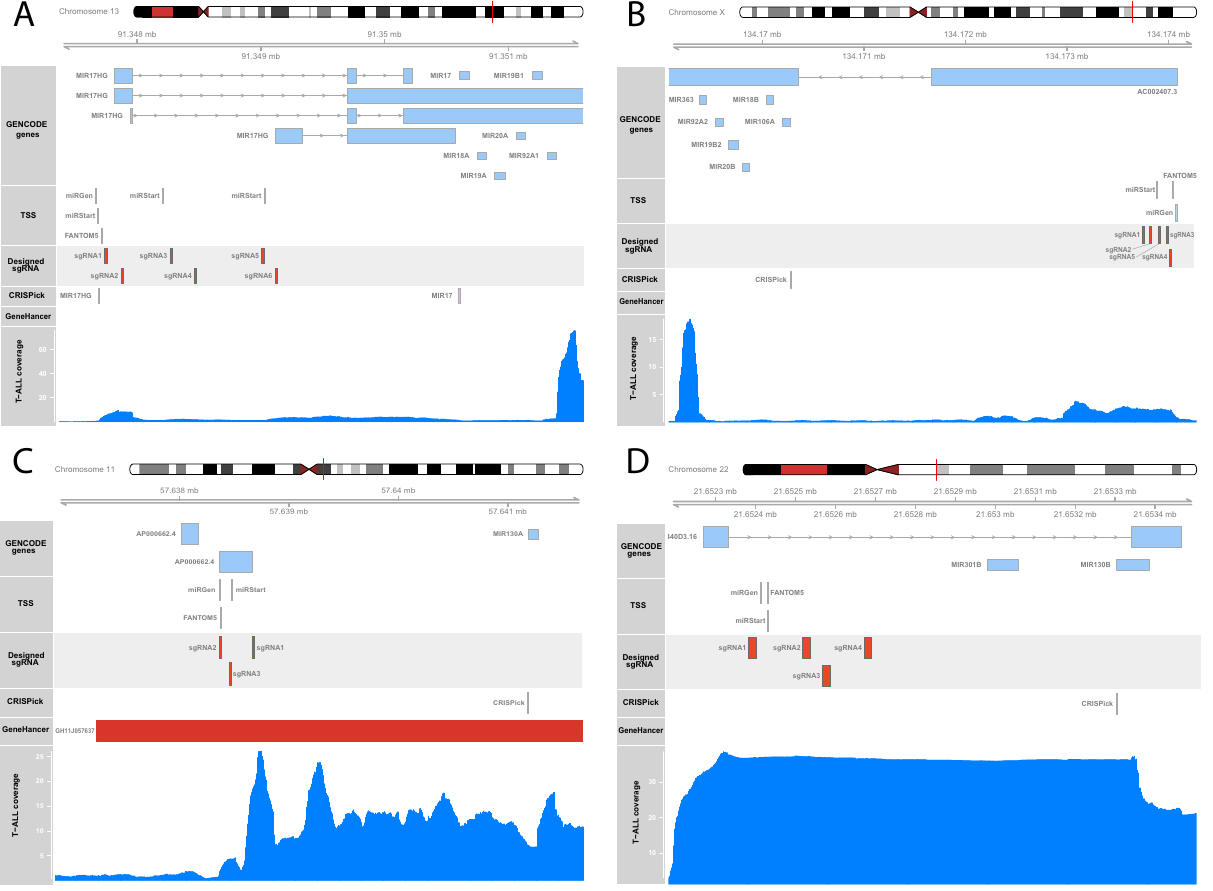
Figure 2. The location of genomic regions targeted by sgRNAs designed to repress the expression of miRNAs. The GENCODE Genes section shows the location of genes and miRNAs in regions of interest. The TSS section shows the location of putative TSSs predicted by miRStart, FANTOM5 and DIANA miRGen v.3 tools. The Designed sgRNAs section shows the positions recognized by sgRNAs tested in the study. The CRISPick section shows the TSSs predicted by CRISPick tool. The GeneHancer section shows the presence of enhancer sequences in the regions of interest, derived from GeneHancer database. The T-ALL Coverage section shows the coverage of reads from RNA-seq data for 64 T-ALL samples mapping to the region of interest. TSS prediction for: ( A ) miRNA cluster mir-17–92; ( B ) miRNA cluster mir-106a-363; ( C ) mir-130a; ( D )